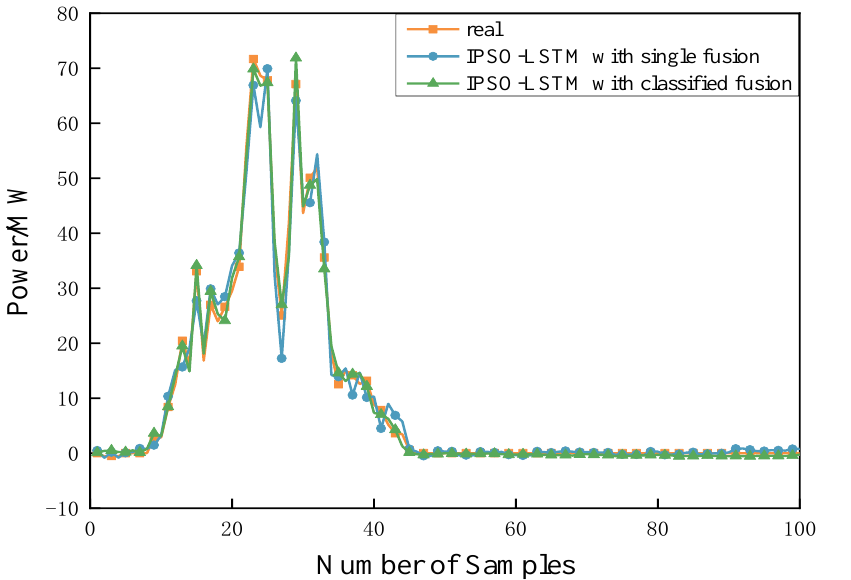
Figure 13. Predicting results of IPSO–LSTM in different fusion patterns. Table 4. Evaluation indexes of IPSO–LSTM in different fusion patterns.